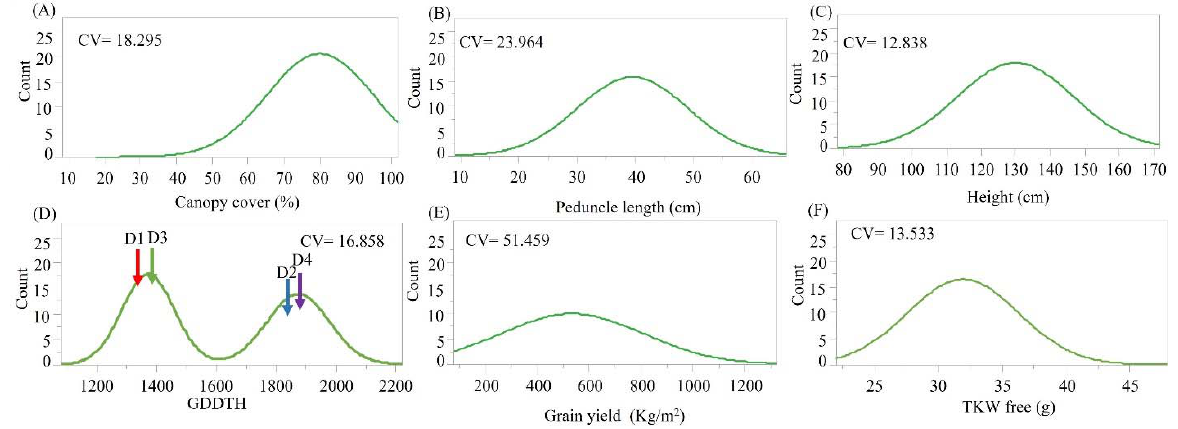
Figure 2. Distribution of phenotypic variables. ( A ) canopy cover (%); ( B ) peduncle length; ( C ) plant height; ( D ) GDD to heading; ( E ) grain yield; and ( F ) TKW. The coefficient of variation values is marked on each chart. Arrows represent cluster phenotypic